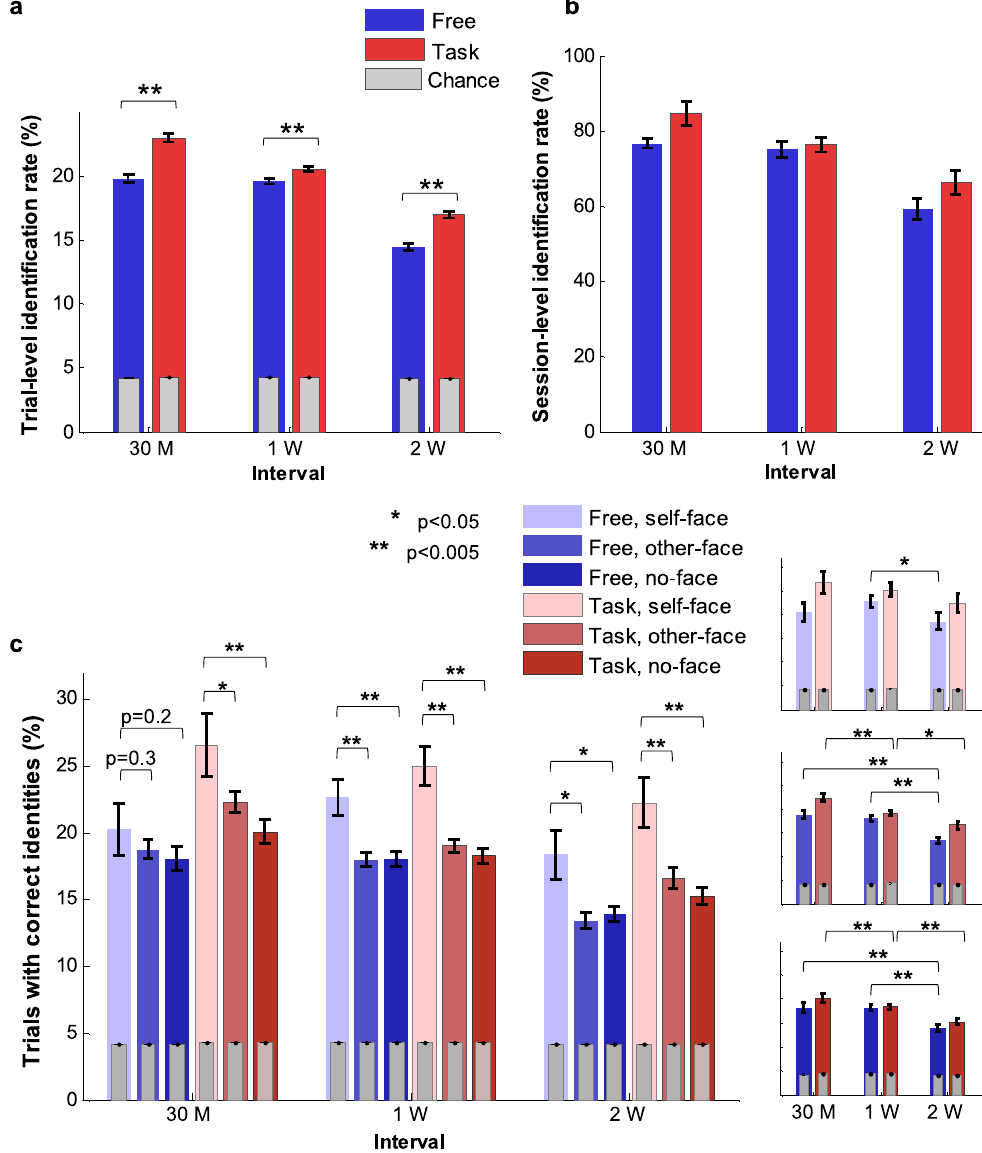
Figure 5. Subject identification performances. ( a ) Average trial-level subject identification rate for each development-evaluation interval (the number of trials for each session condition: n 30M = 660, n 1W = 1,760, and n 2W = 880). Average identification rates with respect to chance levels are compared for different session types and development-evaluation intervals. ( b ) Average session-level subject identification rate for each session type and development-evaluation interval (the number of sessions for each session condition: n 30M = 6, n 1W = 16, and n 2W = 8). ( c ) The ratio of trials that provided correct subject identification decisions in each trial group and for each development-evaluation interval (the number of samples from the self-face group: n 30M = 148 for Free and 146 for Task, n 1W = 404 for Free and 390 for Task, and n 2W = 196 for Free and 200 for Task conditions, from the other-face group: n 30M = 162 for Free and 160 for Task, n 1W = 432 for both Free and Task, and n 2W = 216 for both conditions, and from the no-face group: n 30M = 162 for both, n 1W = 430 for both, and n 2W = 216 for Free and 214 for Task conditions). These results are compared with respect to groups and development-evaluation time intervals. The error bars in ( a )–( c ) represent standard errors. The sample numbers for different trial groups and session conditions in ( c ) are not exactly the same due to invalid